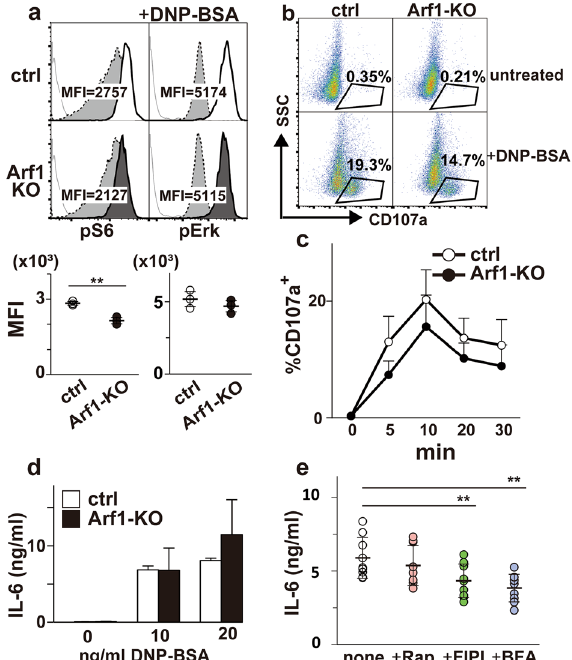
Figure 4. Degranulation reaction is normal in Arf1-deficient BMMCs. ( a ) Either control (ctrl; n = 3) or Arf1-KO (n = 3) BMMCs at 5-week after culture sensitized with anti-DNP IgE were stimulated without (dotted line) or with (solid line) 20 ng/mL of DNP-BSA for 20 min and evaluated for pS6 (left) and pErk (right) signals by FACS. Shown are representative FACS profiles (top) and mean fluorescence intensities (MFI) (bottom). Gray thin lines on FACS plot indicate negative stained signal with isotype controls. Mean ± SD. ( b ) Control (ctrl) or Arf1-KO BMMCs sensitized with anti-DNP IgE were stimulated without (untreated) or with (+ DNA-BSA) 20 ng/mL of DNP-BSA for 20 min. Shown are FACS profiles and proportion of CD107a + cells representative of four. ( c ) Proportions of CD107a + cells in control (ctrl) or Arf1-KO BMMCs stimulated as in ( b ) for the indicated time periods were evaluated by FACS (n = 4, each). ( d ) Control (ctrl) or Arf1-KO BMMCs sensitized with anti-DNP IgE were stimulated with the indicated concentrations of DNP-BSA for 24 h ( d ; n = 5, each). Concentrations of IL-6 in the culture supernatants were then quantified by ELISA. ( e ) Control BMMCs sensitized with anti-DNP IgE were stimulated with 20 ng/mL of DNP-BSA along without (none) or with 0.1 µM of rapamycin (+ Rap), 0.1 µg/mL of FIPI (+ FIPI), or 0.1 µM of BFA (+ BFA) for 24 h (e; n = 9, each). Concentrations of IL-6 in the culture supernatants were then quantified by ELISA. ** p <